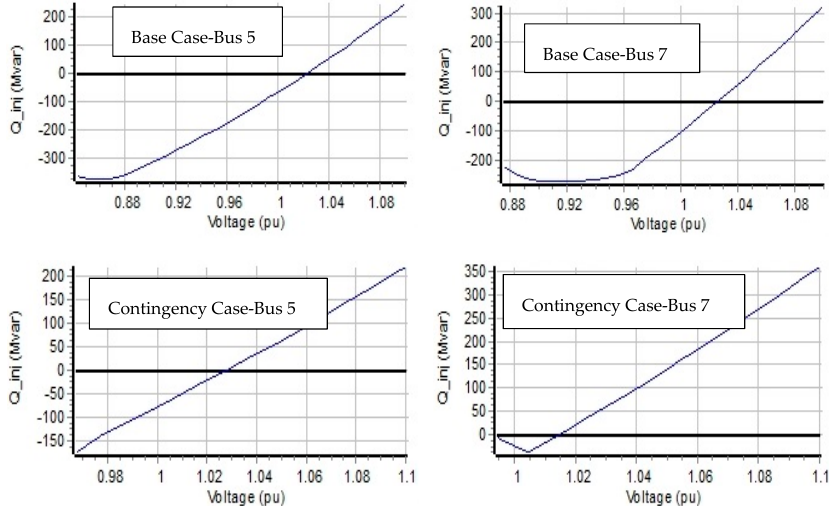
Figure 21. Q-V curves of buses 5 and 7 after adding a shunt capacitor to bus 6.